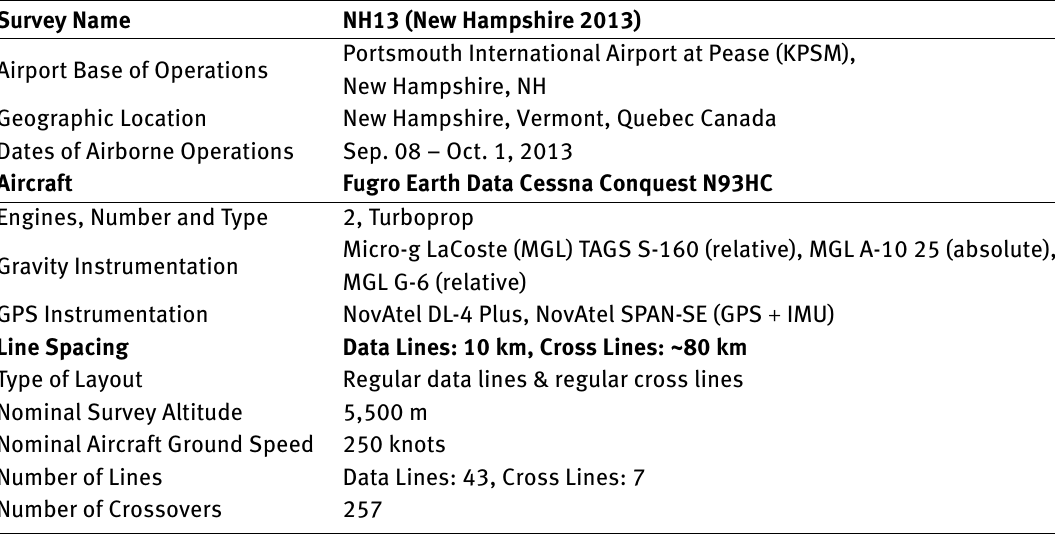
Table 8: Synopsis of survey layout and execution for New Hampshire test area